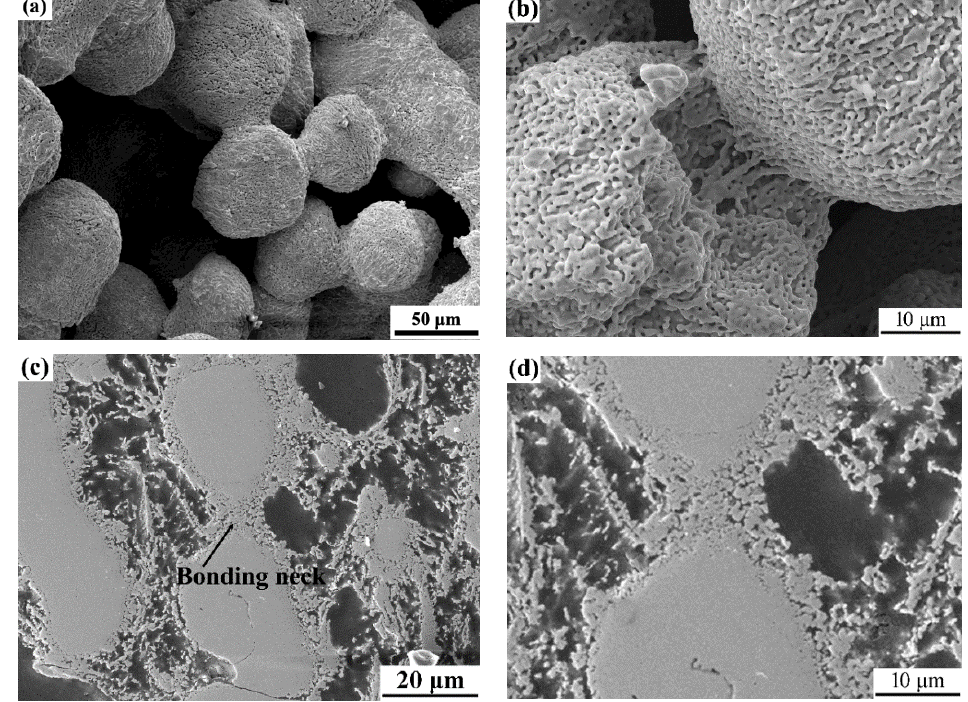
Figure 4. Surface morphology of reduced porous Mo ( a , b ) and cross-sectional microstructure of inter-particle bonding neck ( c , d ).